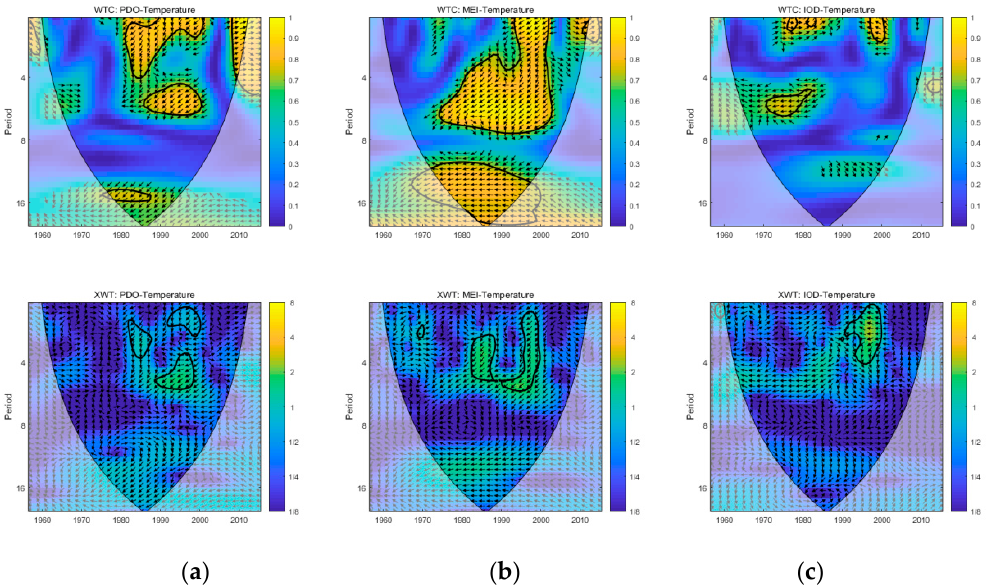
Figure 11. Wavelet coherence and cross wavelet transform of the annual average air temperature with ( a ) PDO, ( b ) MEI, and ( c ) IOD (1957–2015). The meaning in the figure is the same as in Figure 10.